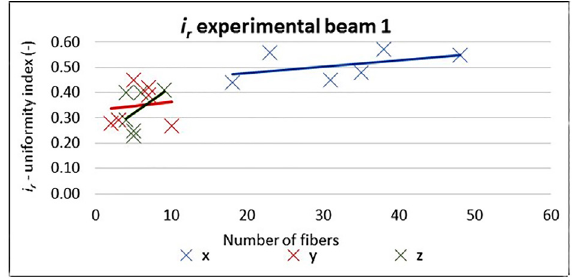
Figure 11. Output chart with i r experimental beam 1